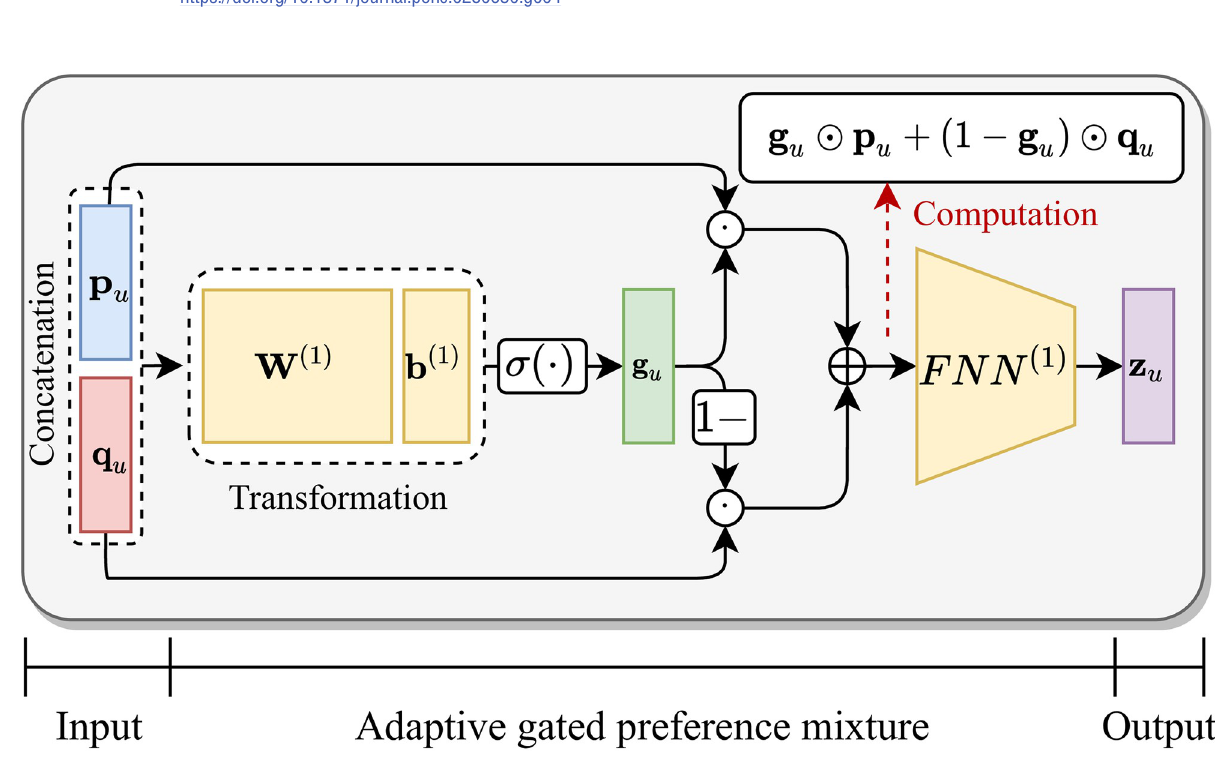
Fig 5. The architecture of adaptive gated preference mixture (PreMix).